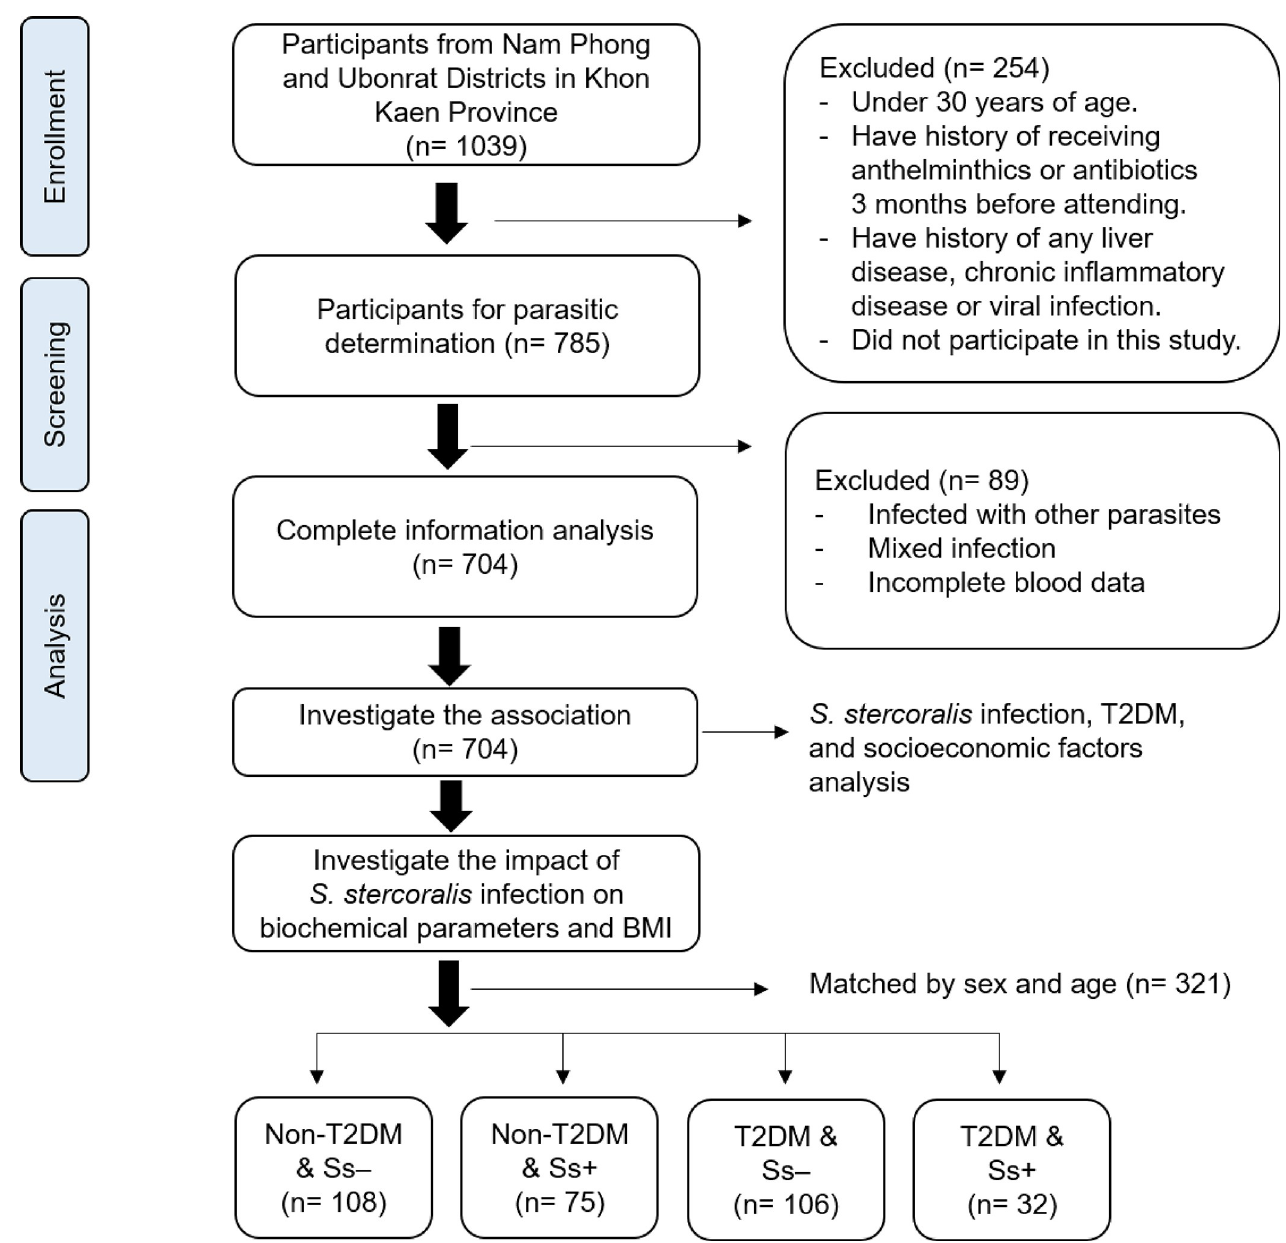
Fig 2. Flow diagram of the study participants and study design to investigate the association between S . stercoralis infection, T2DM and socioeconomic factors (n = 704), and their impact on BMI and kidney-related biochemical parameters (n = 321).